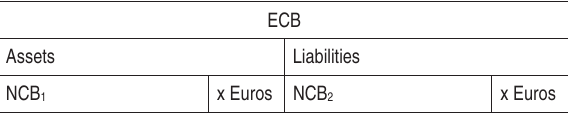
Table 3. The first phase of a cross-border payment as seen from the ECB viewpoint